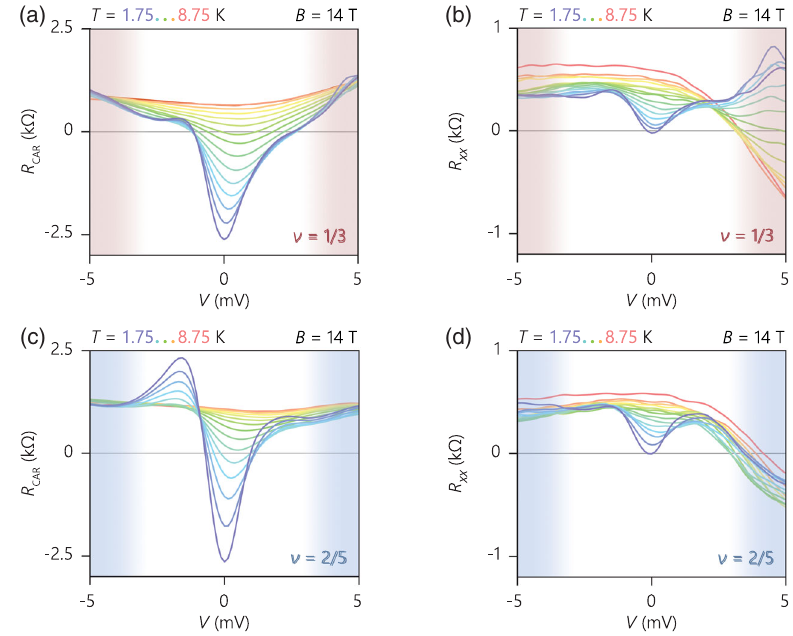
FIG. 15. Transport spectroscopy in device 1 showing R edge mode potential V (excitation) for different temperatures T . Crossed Andreev reflection ( R j